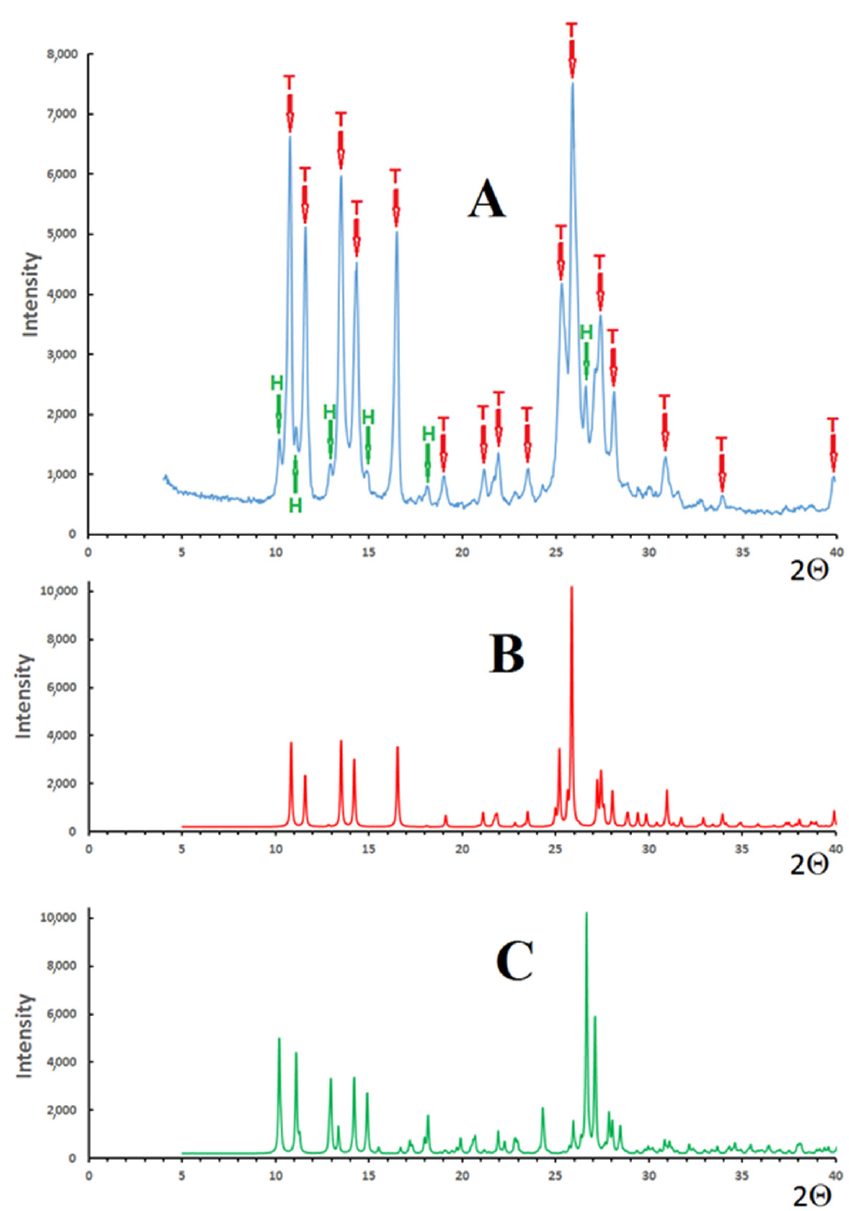
Figure 3. ( A ) experimentally recorded diffractogram of dioxidine obtained at zero flow of carrier gas (CO 2 ), ( B ) theoretical diffractogram of dioxidine triclinic phase (T-phase) [41], ( C ) theoretical diffractogram of 1/3 dioxidine crystalline hydrate (H-phase) [41].